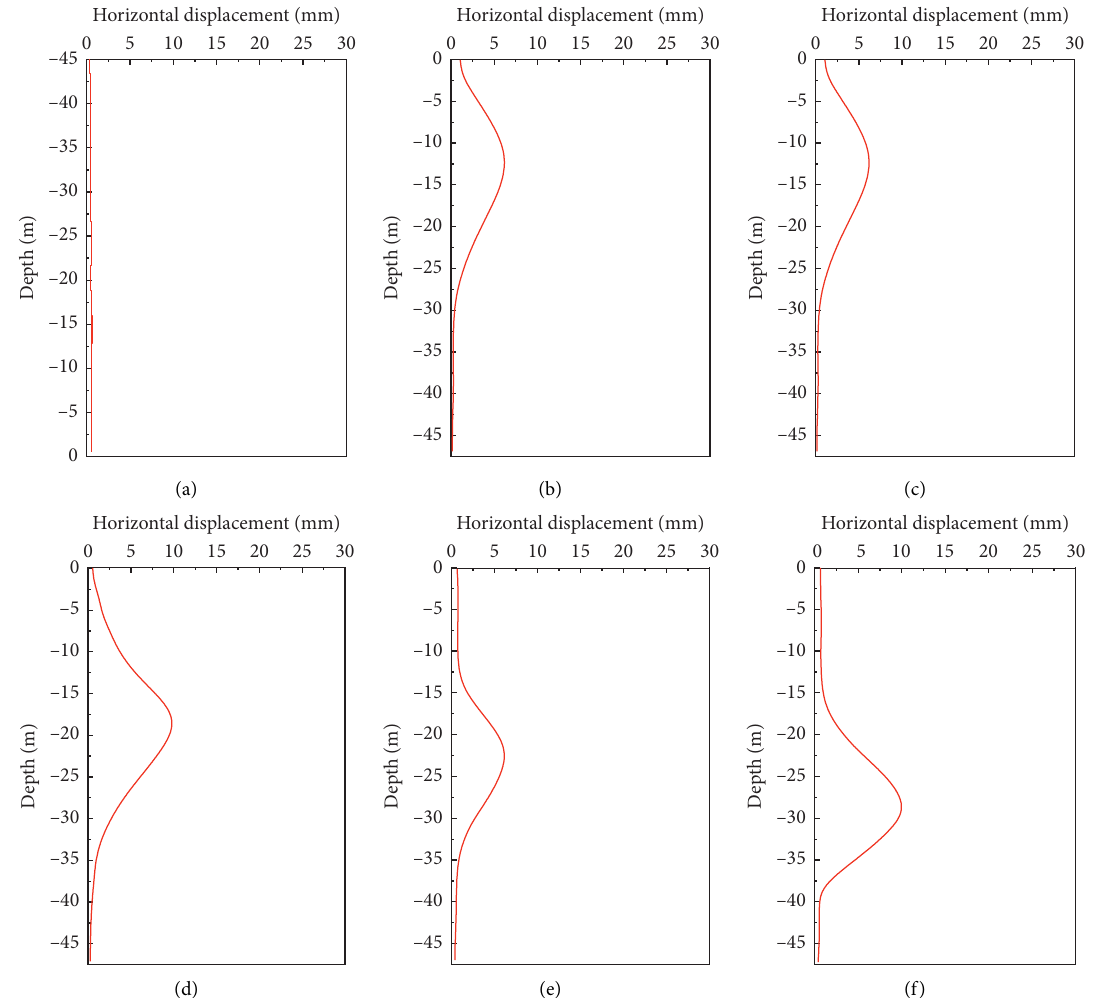
Figure 8: Calculation results of horizontal displacement of the continuous wall in each step. (a) Step 1 construction. (b) Step 2 construction. (c) Step 3 construction. (d) Step 4 construction. (e) Step 5 construction. (f) Step 6